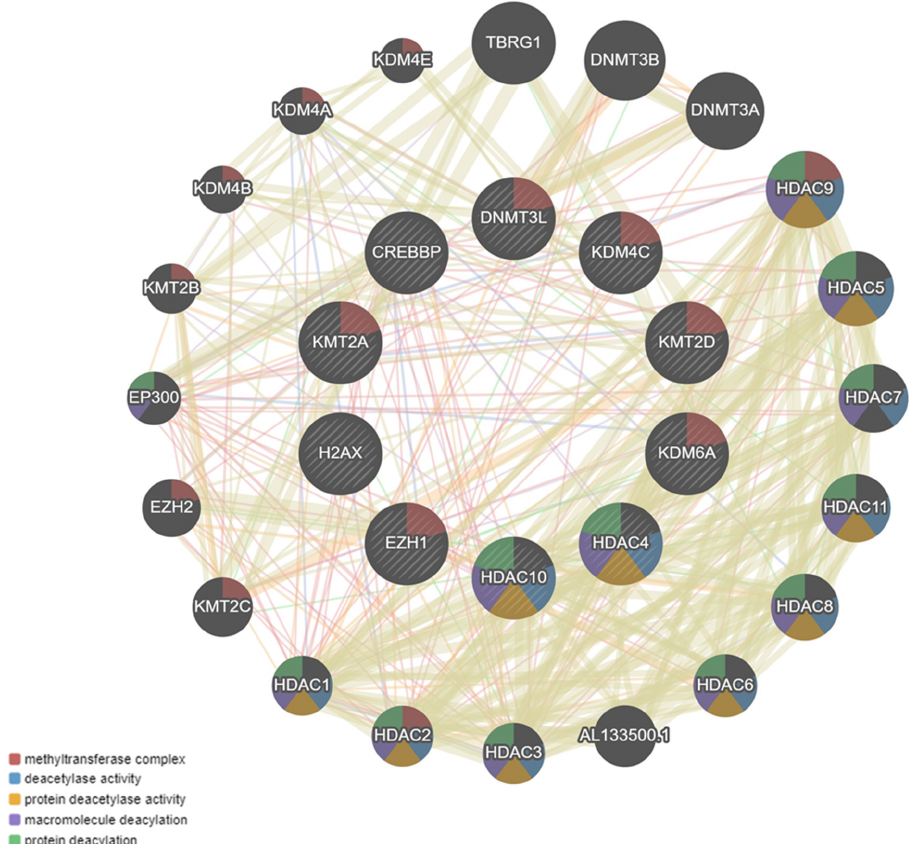
Figure 1. Co-expression interaction network obtained with the 10 significantly overexpressed genes associated with muscle function evaluated. Appl. Sci. 2022 , 12 , 1159